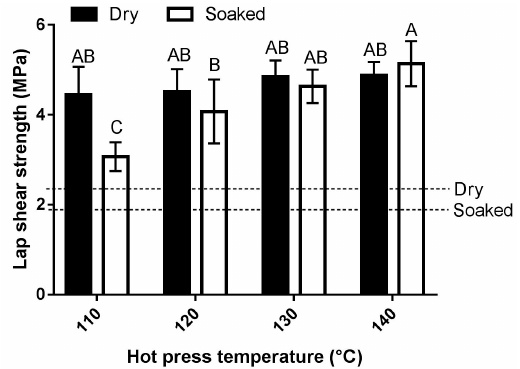
Figure 4. Effect of hot press temperature on lap shear strength of plywood specimens bonded with the peptides–PAE adhesive. For these experiments, a formulation consisting of 46% PAE resin and 54% peptides was used after crosslinking for 120 min. Specimens were hot pressed at 3.5 MPa for five min. Error bars are standard deviation of six plywood specimen measurements. Means that do not share a letter are significantly different (Tukey, 95% confidence level). The minimum shear strength requirements as specified by ASTM D4690 are indicated.